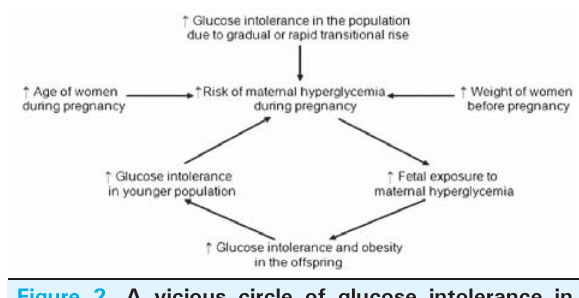
Figure 2. A vicious circle of glucose intolerance in younger population and maternal hyperglycemia during pregnancy The safe level of maternal blood glucose during pregnancy Chances of having macrosomia, birth weight